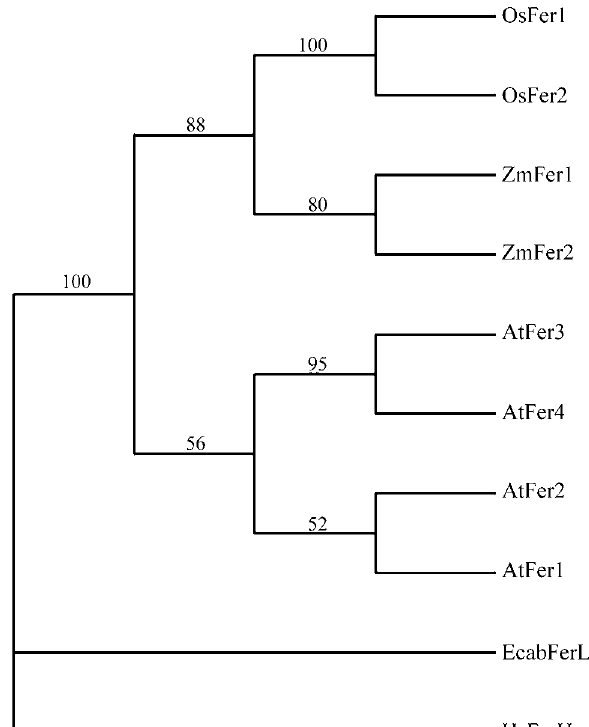
Figure8 -Phylogeneticrelationshipsof Oryzasativa Ferritinstoplantand mammalian Ferritins. The proteins are from Oryza sativa (OsFer1: AAM74942; OsFer2: AAM74943), Zea mays (ZmFer1: CAA58146; ZmFer2: CAA58147), Arabidopsis thaliana (AtFer1: CAA63932; AtFer2: CAC85498; AtFer3: CAC85399; AtFer4: CAC85400) and the mammalian homologues Homo sapiens heavy chain (HsFerH: CAA25086) and Equus caballus heavy chain (EcabFerH: